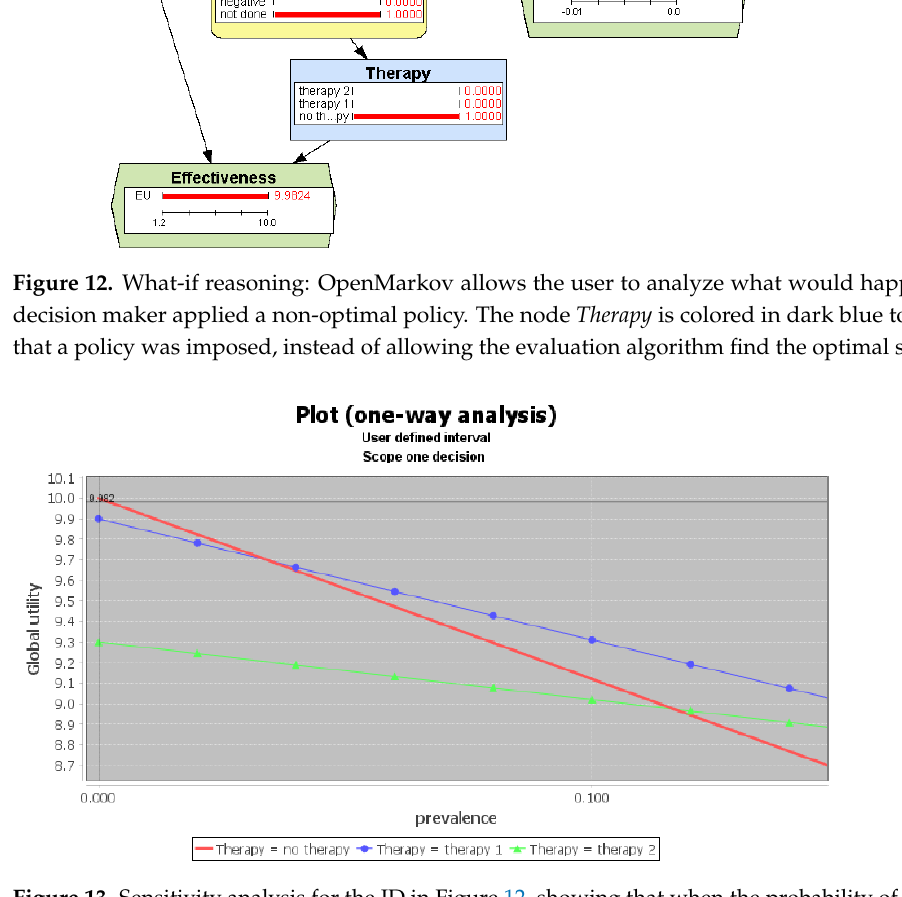
Figure 13. Sensitivity analysis for the ID in Figure 12, showing that when the probability of disease is below 0.0345, the best option is no therapy.